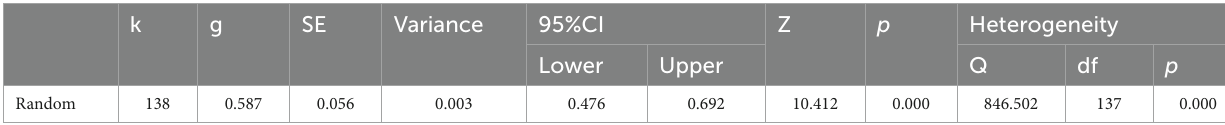
TABLE 2 Overall effect